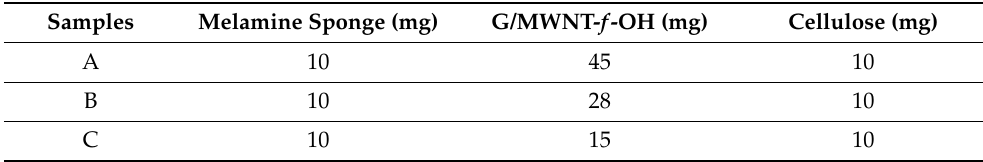
Table 1. The ratio of the as-prepared modified melamine sponges.